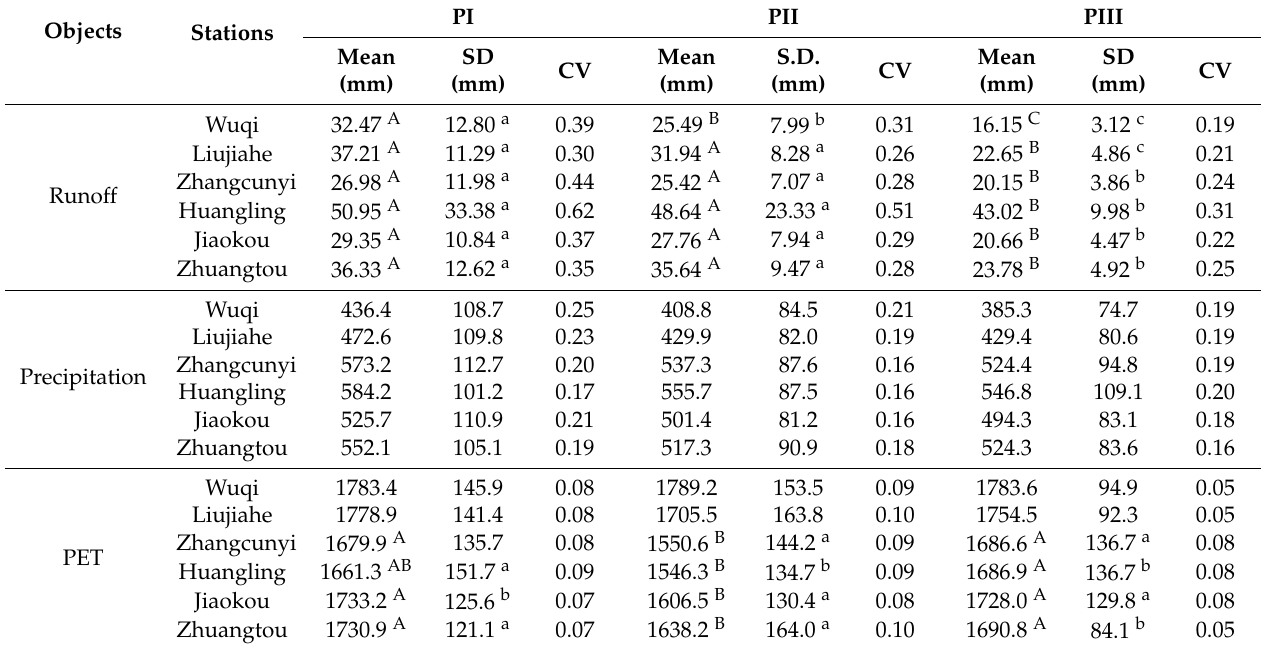
Table 4. Summary of the annual streamflow, precipitation, and PET